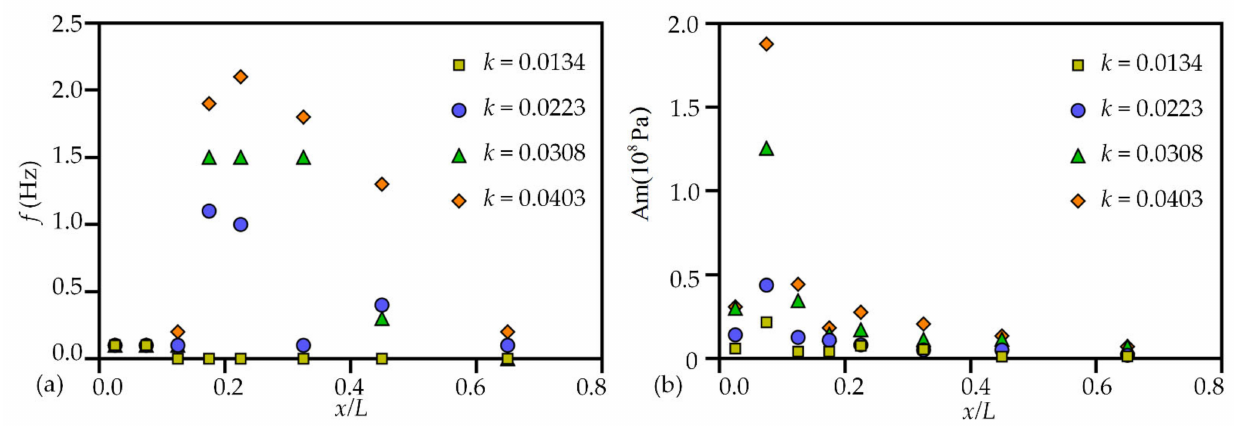
Figure 13. ( a ) Advantage frequency table shows that k = 0.0134; k = 0.0223; k = 0.0308; k = 0.0403, the main frequency of the characteristic points of the bottom of the stilling pool; ( b ) Marginal spectrum amplitude table shows the marginal spectral amplitude of the characteristic points on the bottom of the stilling pool when k = 0.0134; k = 0.0223; k = 0.0308; k =